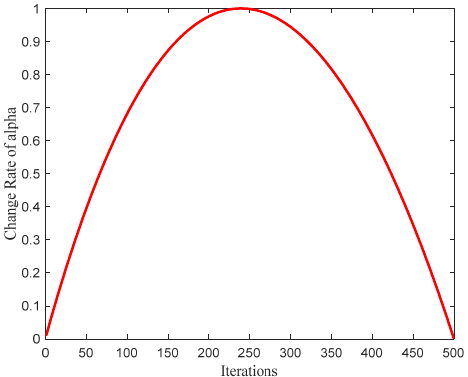
α . Figure 2. Change of step size factor α